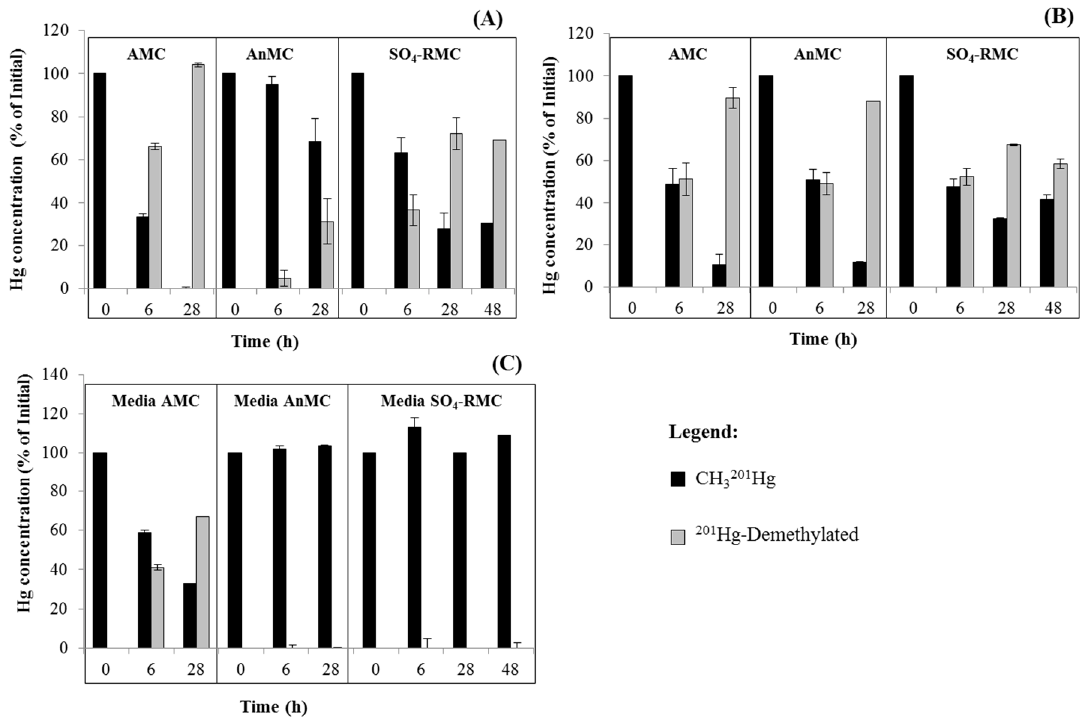
Figure 4. Concentration of CH 3201 Hg after 6, 28, and 48 h of incubation with the three microbial communities of aerobic microbes (AMC), anaerobic microbes (AnMC), and sulphate-reducing microbes (SO 4 -RMC) isolated from Cala do Norte ( A ) and Barreiro ( B ). The control media were also evaluated ( C ).